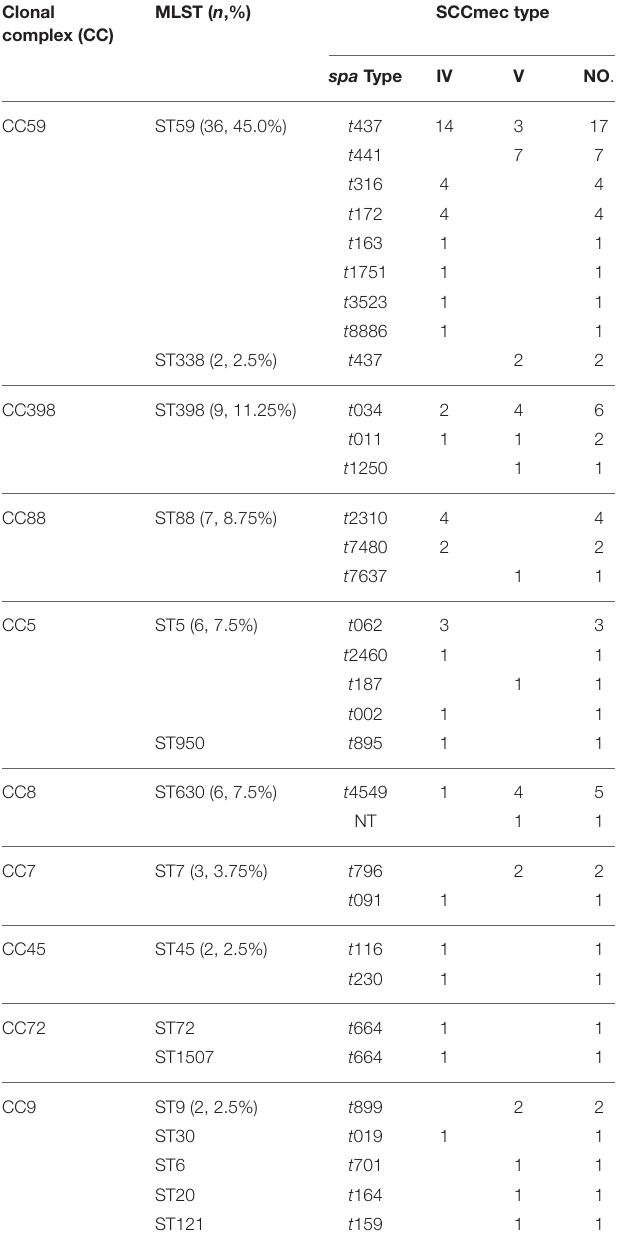
TABLE 1 | Clonal complexes and the relationship among the molecular types of MRSA isolates from pediatric patients. Clonal MLST ( n ,%) SCCmec type complex (CC) spa Type IV V NO . CC59 ST59 (36,